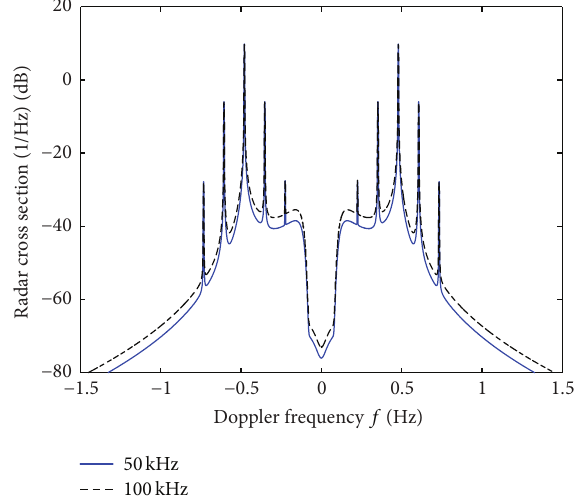
Figure 4: The effect of the bandwidth on the first-order radar cross sections.